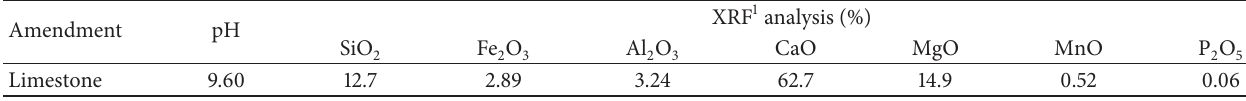
Table 1: pH and XRF analysis results of the soil amendment used in this study.